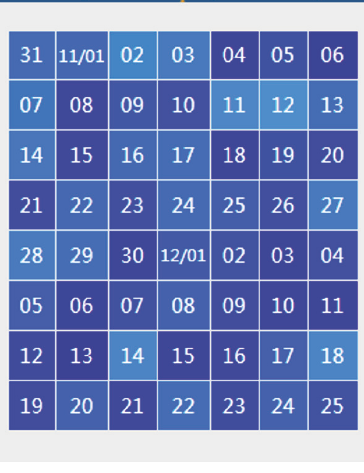
Figure 12: The fourth part of visualization web pages.